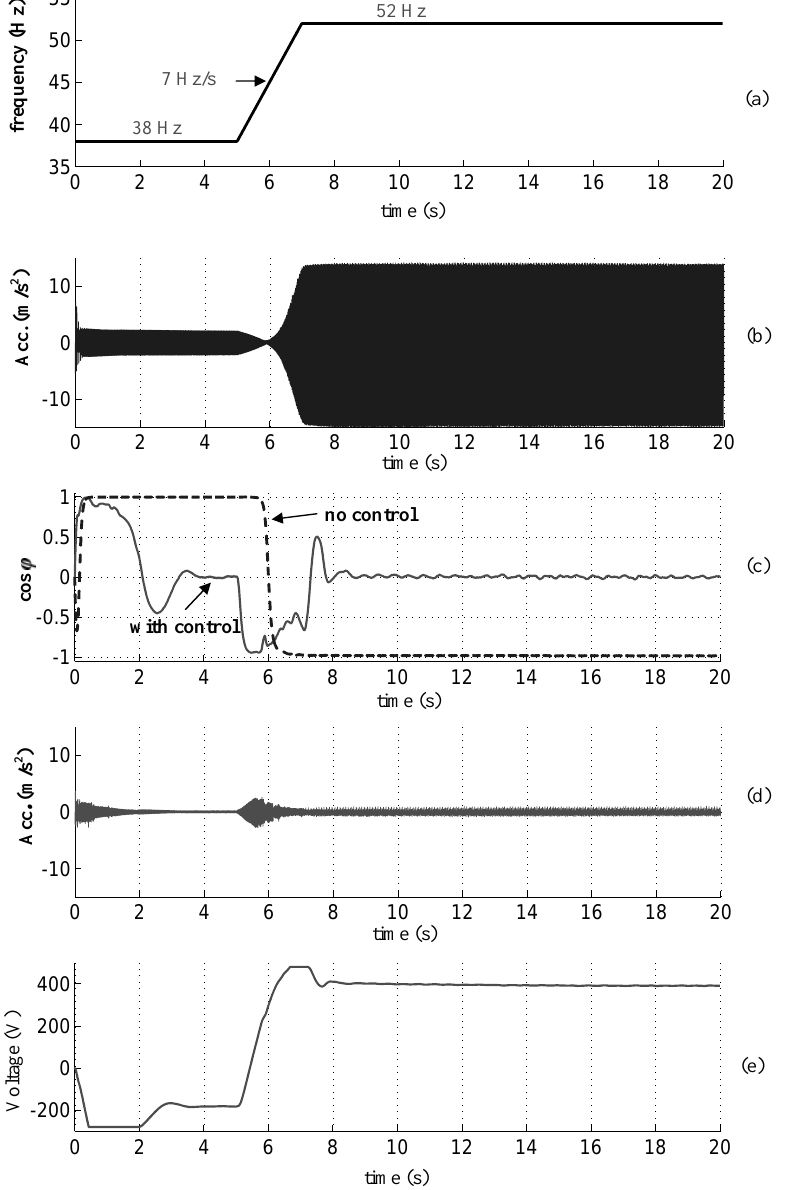
Fig. 16. Experimental results for variable frequency harmonic excitation. (a) frequency variation; (b) vibration ¨ x without control, piezo-actuators at 0 V; (c) cosine of φ ; (d) controlled vibration ¨ x ; (e) variation of controlled voltage applied to piezo-actuators; for control results P = 4 × 10 − 2 , D = 8 × 10 − 3